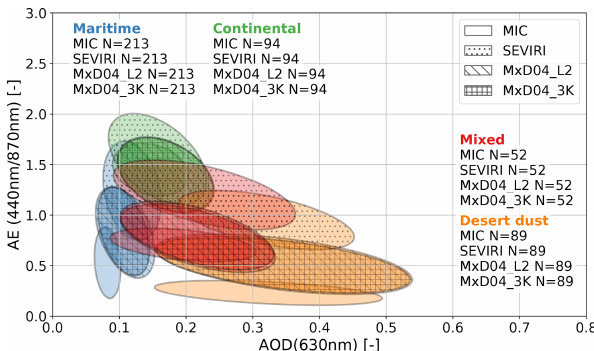
Figure 7. Comparison of AE calculated from AOD at the wave- lengths of 440 and 810nm versus AOD at 630nm calculated from the Microtops, SEVIRI, and MODIS products. Simultaneous data availability from satellites and MIC is required so that each instru- mental data points has a corresponding counterpart from the other instruments. The data points are grouped by aerosol type (classi- fied with MIC) and visualized as covariance ellipsoids for a 67% confidence